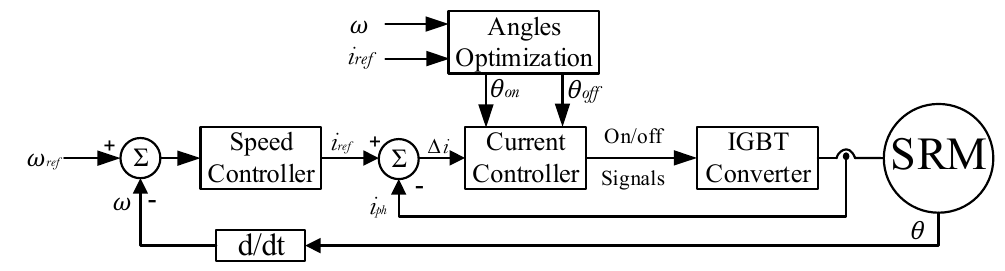
Figure 2. Block diagram of the proposed ATC control.